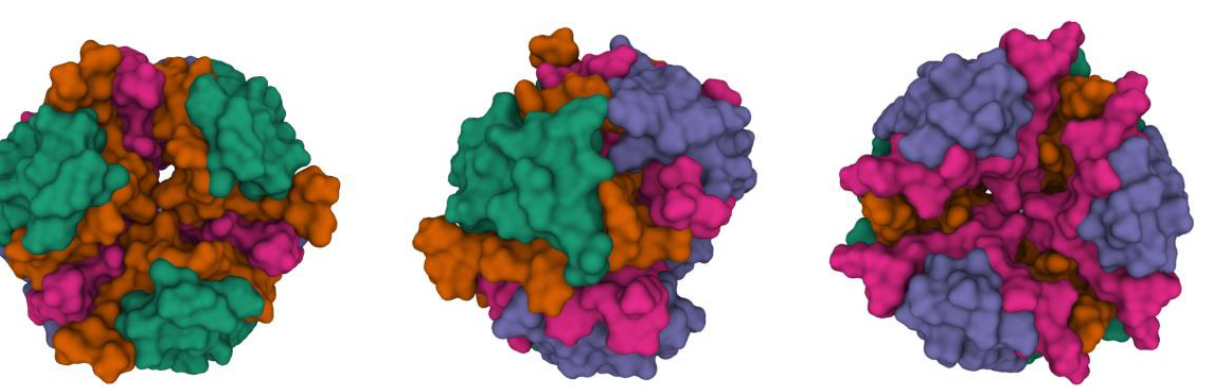
Figure 1. A simplified presentation of a human insulin monomer, based on the X-ray crystal structure (PDB ID: 5ENA), where only the secondary structure of the protein is shown, the A chain is marked with green and the B chain with orange, and the small red dots are the water molecules [7,8]. The insulin active form is a monomer (containing an A and a B chain). These monomers can easily associate into a dimer form (containing chains A, B, C and D), and later to a tetramer and hexamer form. These hexamers can make a stable complex by binding two Zn 2+ ions (or other bivalent metal ions). Figure 2 shows a stable hexamer complex with two Zn 2+ ions.